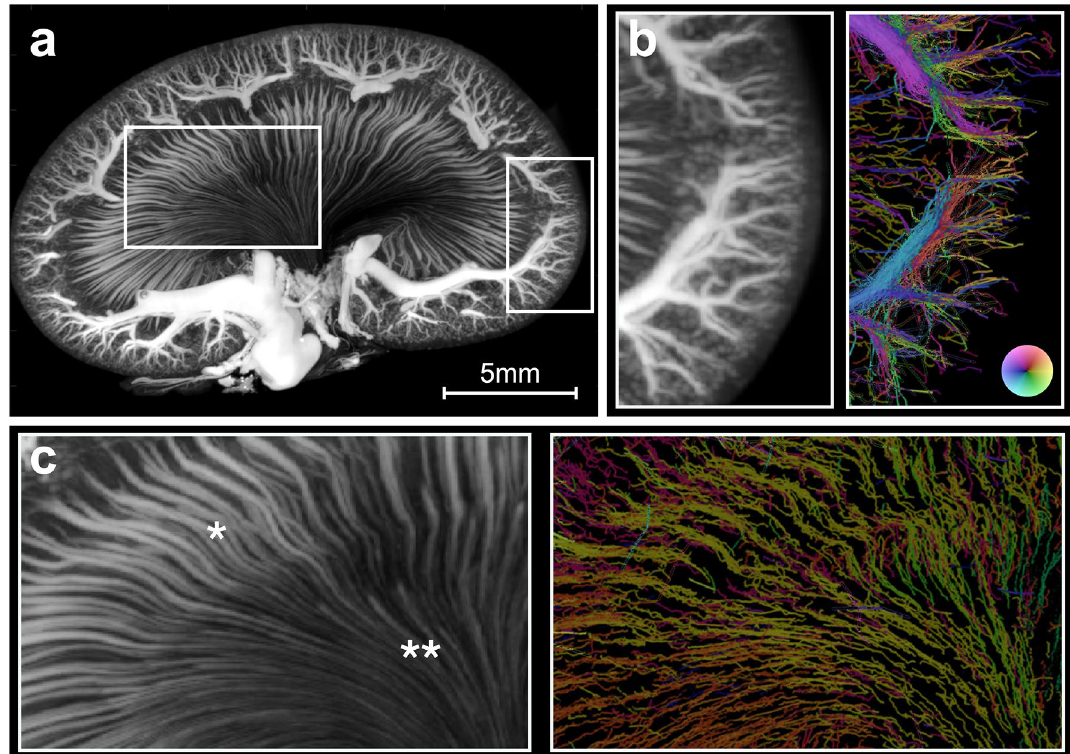
Figure 2. Visual comparison of the μ CT and microbubble track map. ( a ) μ CT maximum intensity projection in the super-resolution ultrasound image overlap of scan 1. The two marked regions are up-scaled and compared with the corresponding unfiltered microbubble track map in ( b ) and ( c ) (for visualization, the color transparency in the microbubble track map is scaled by the intensity map). ( b ) Shows a part of the renal cortex. ( c ) Shows a part of the renal medulla with the vasa recta. Notice how the color wheel in the microbubble track map allows separation of arteries and veins according to flow direction, e.g . , in ( c ) with the descending (orange/ yellow/green) and ascending (purple/blue) vasa recta of the medulla. * marks outer medulla, ** marks inner